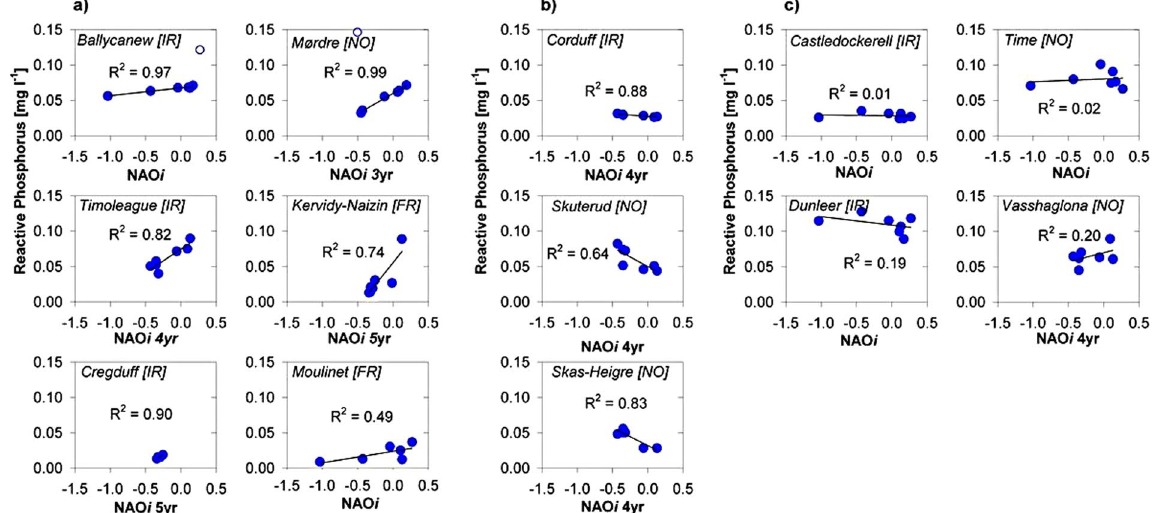
Figure 3. Linear correlation of Reactive P concentrations in rivers to NAO i . Annual averages (hydrological years, October - September) of reactive phosphorus concentrations correlated to NAO i : ( a ) positive correlations, ( b ) negative correlations and ( c ) no correlations in Irish, Norwegian and French catchments with different flow controls, farm management, weather response to NAO change, P retention and storage capacity. NAO i are expressed as antecedent zero to five-year simple moving averages depending on the specific catchment response time.